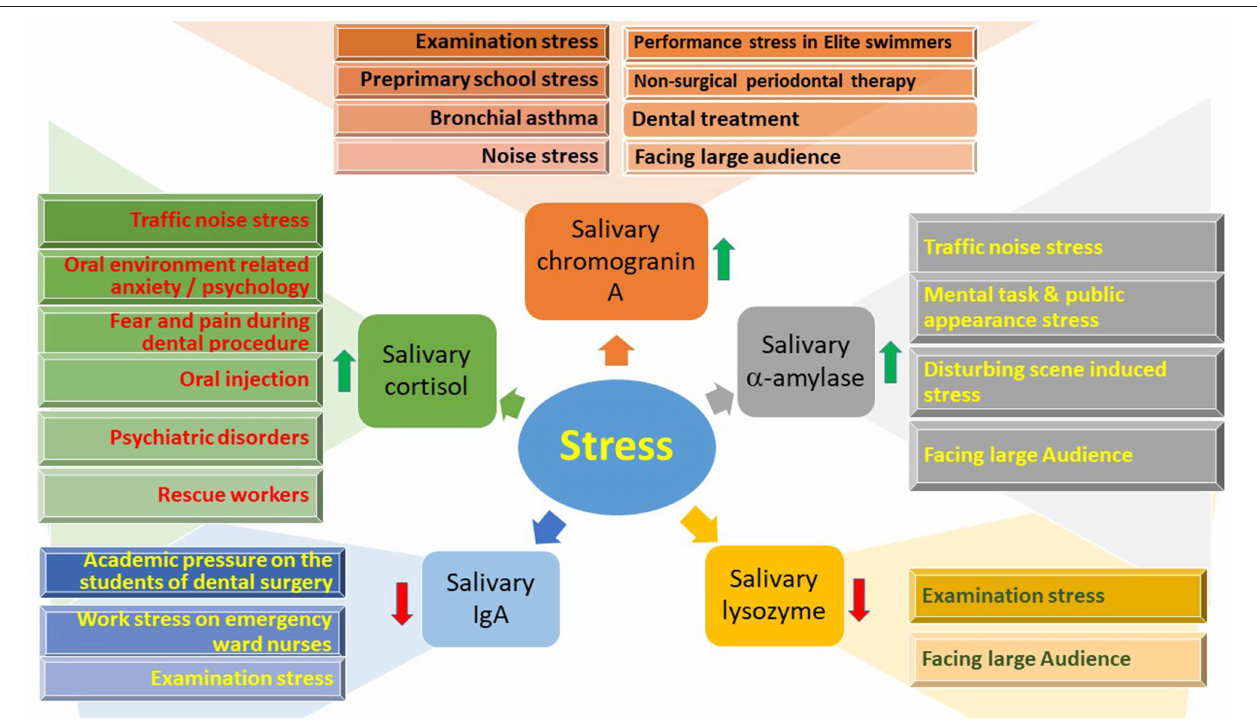
FIGURE 5 | Various stresses affecting the salivary stress biomarkers: cortisol, chromogragranin A and α -amylase are increased whilst salivary IgA and lysozyme are decreased with an increase in level of